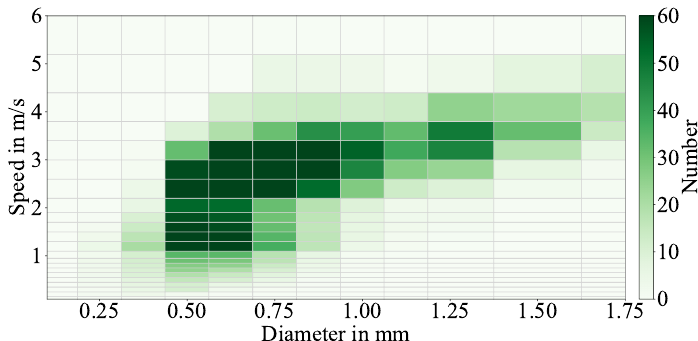
Figure 7. Example of a speed-diameter histogram taken with the OTT Parsivel disdrometer under 120 mm/h.